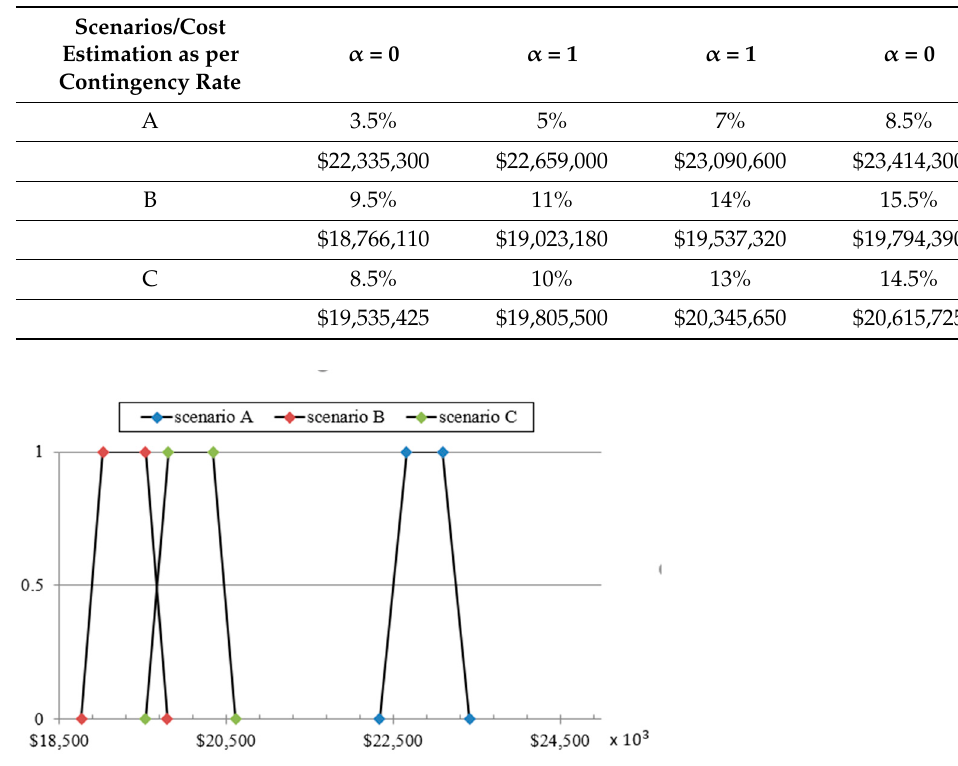
Figure 3. Fuzzy model of each scenario for hydraulic fracturing cost from base estimate.